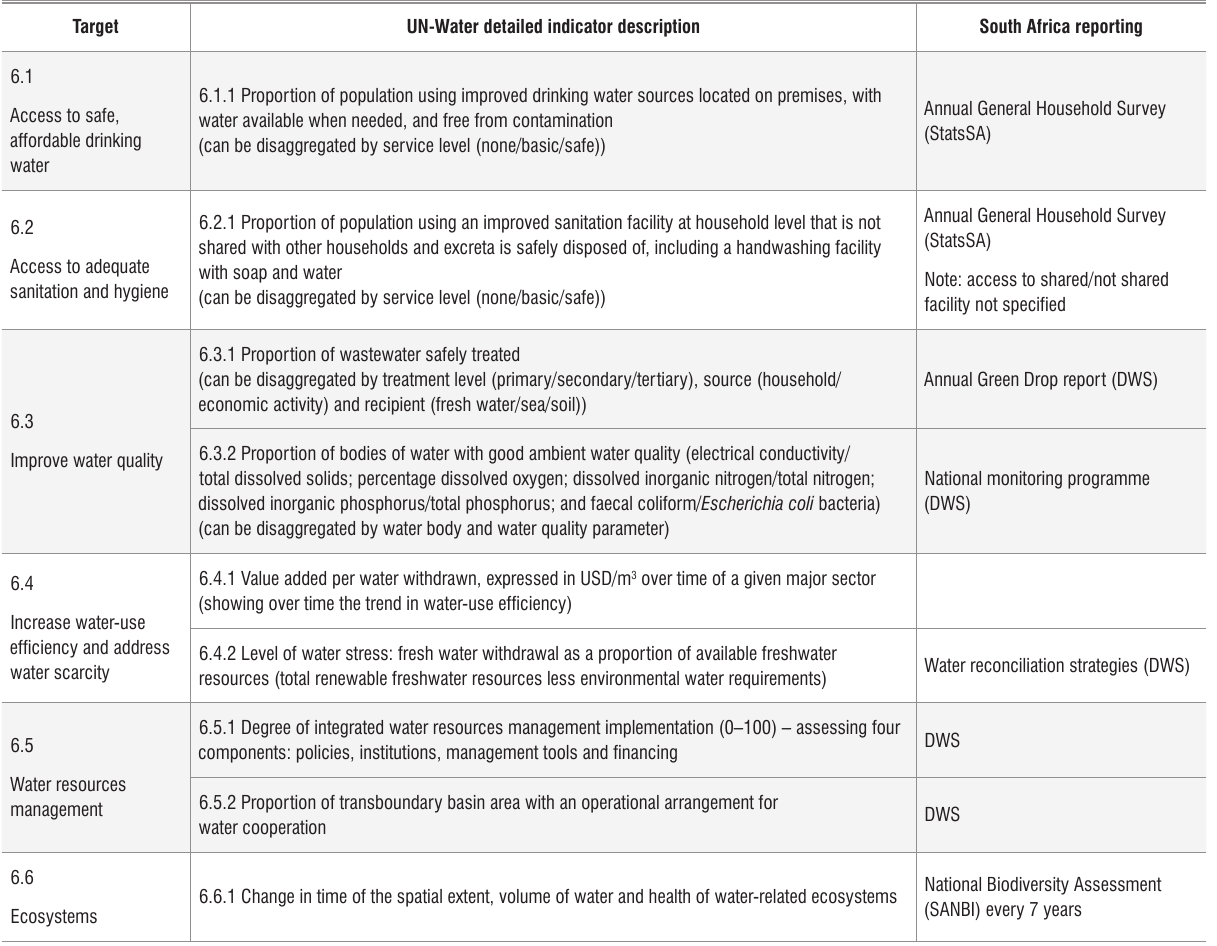
Draft Sustainable Development Goal 6 global indicators 4,12